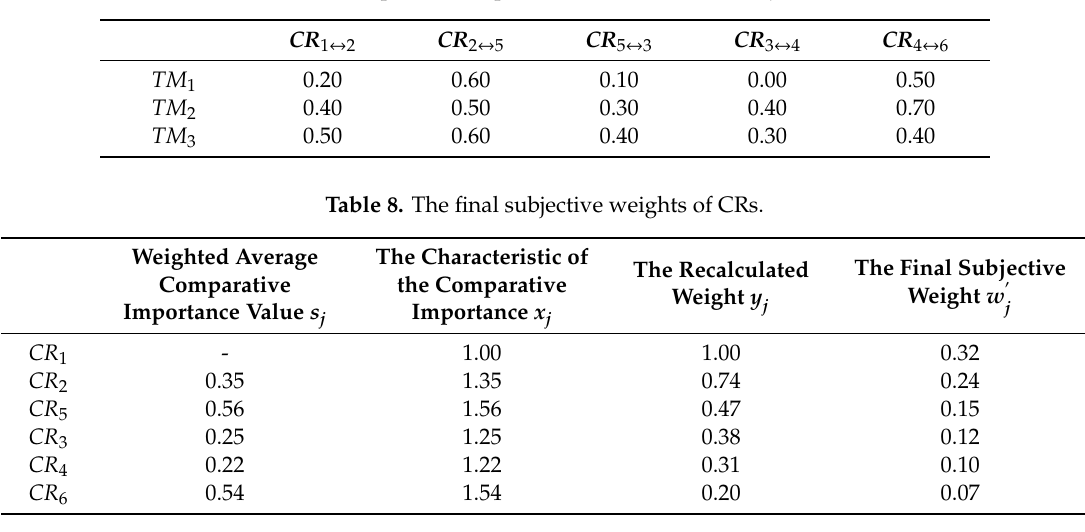
Table 7. The comparative importance values between adjacent CRs.